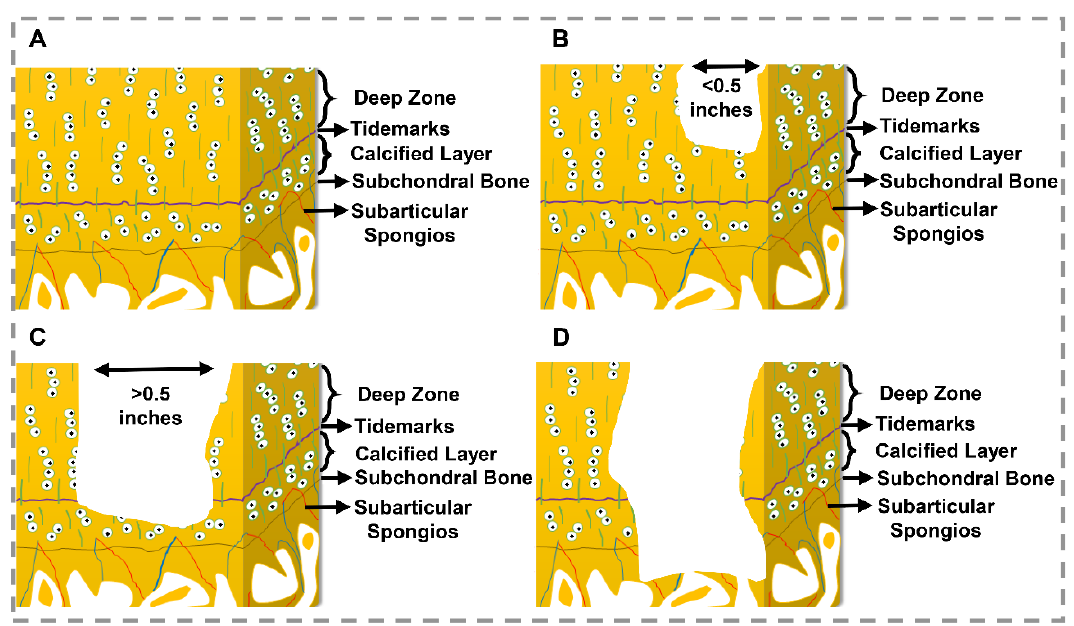
Figure 1. Osteochondral defect grades. ( A ) Normal cartilage (grade 0), ( B ) Moderate lesion (grade I: partial-thickness defects), ( C ) Sever lesion (grade III: full-thickness defects), ( D ) Very sever lesion (grade IV: osteochondral defect) [24,30,31].